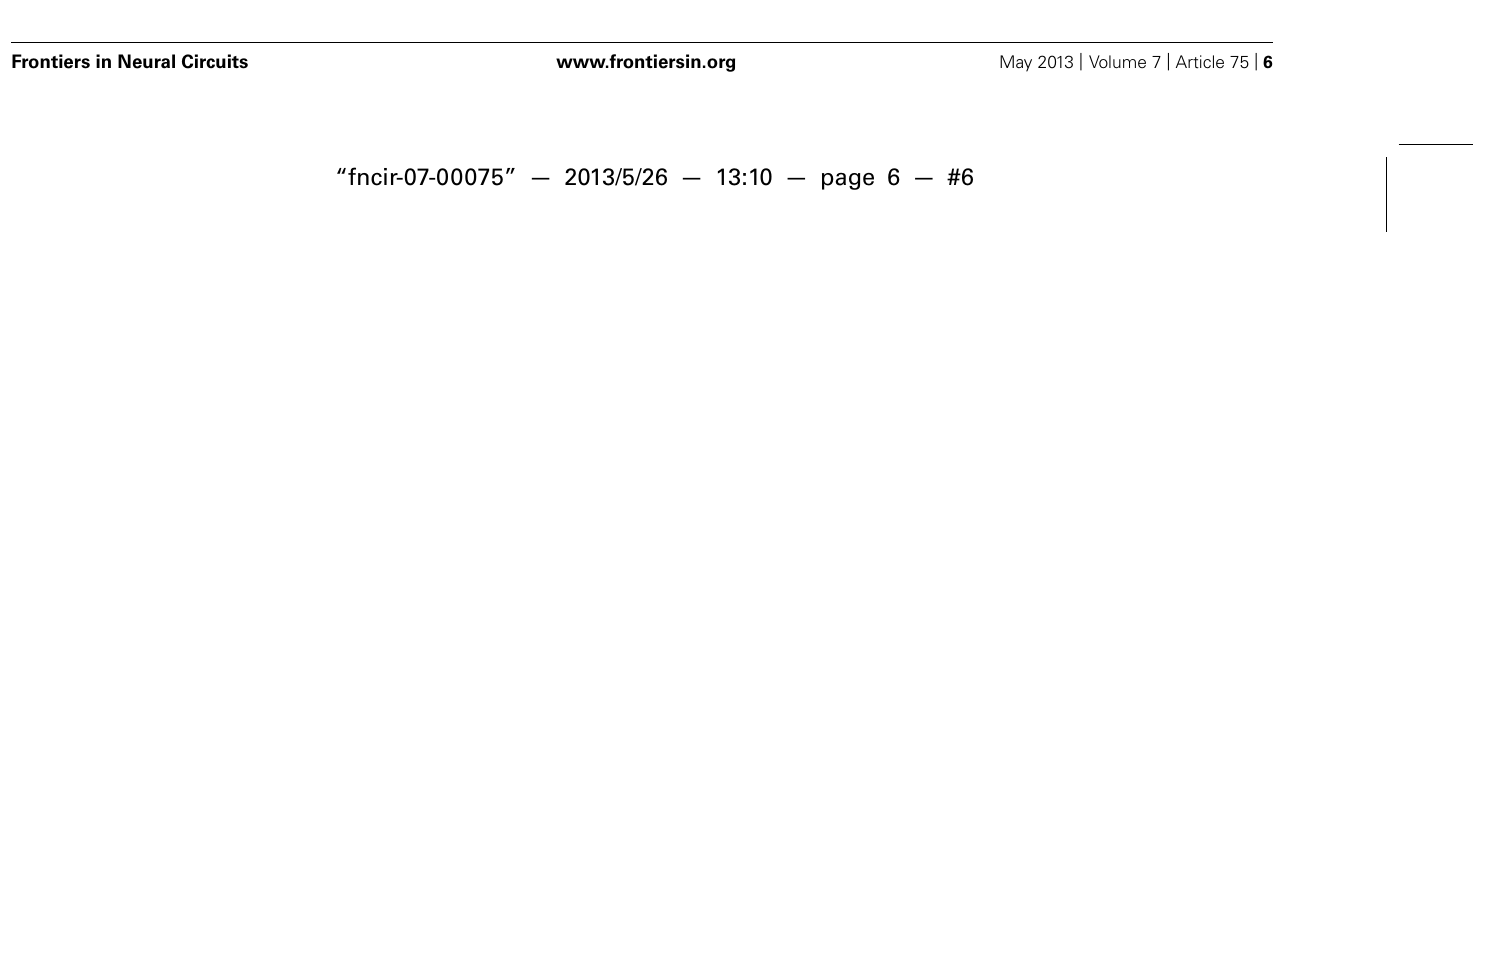
FIGURE 3 |Axonal arborization of an EZ neuron in comparison with that of primary sensory thalamic neurons in rats. The axons of EZ neurons were distributed very widely, often in the cortical area spanning more than 5 mm (A,B) .This distribution is in sharp contrast to those of sensory thalamic neurons, such as neurons in theVP and dorsal lateral geniculate nucleus (LGd).The axonal arborization ofVP and LGd neurons was concentrated to